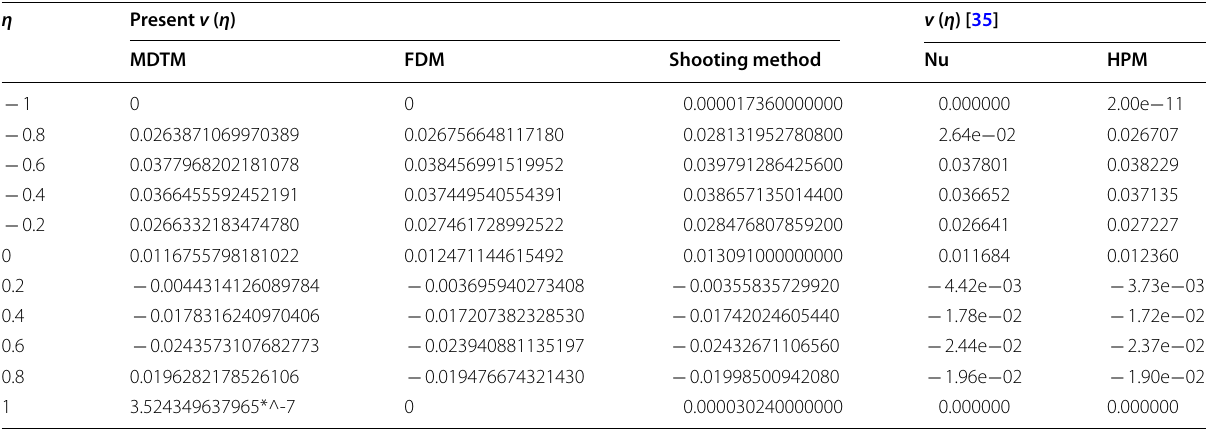
Table 5 Comparison solution by MDTM, FDM, and shooting method with Nu and HPM [35] for V ( η ) when ϕ Ha 0, 1 R 0, Ec 2, Pr 6.2, and α d = = = =